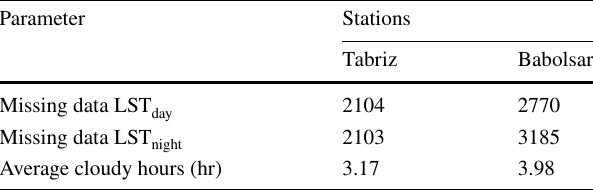
Table 4 The input combinations of the studied models